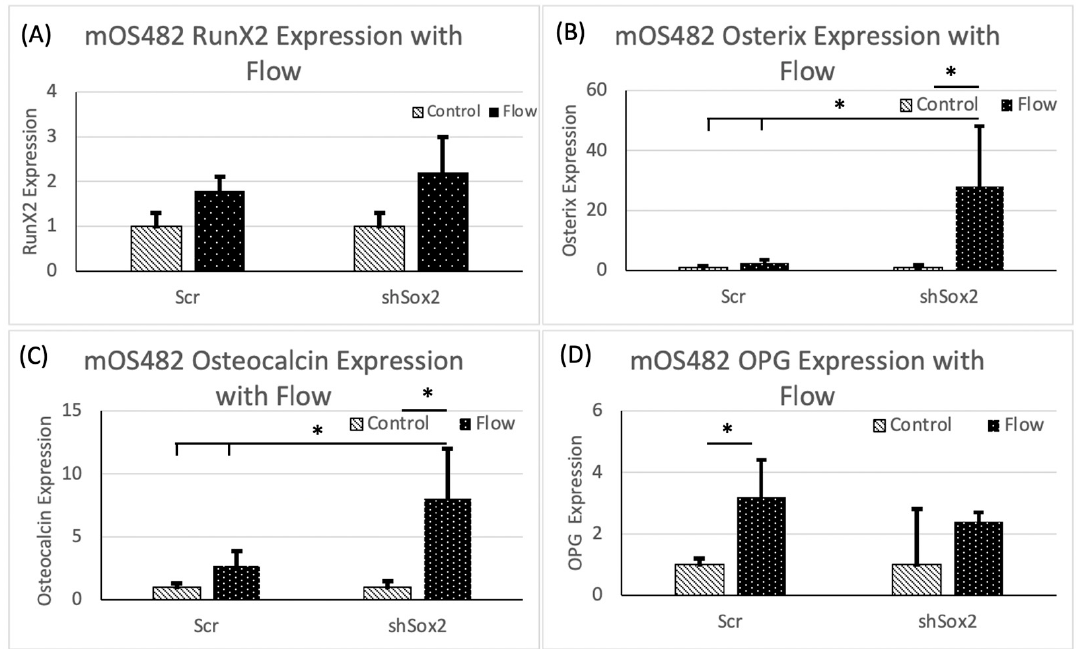
Figure 3. Evaluation of osteogenic gene expression in scr and shSox2 treated cells as a function of FFSS. Quantification of ( A ) Runx2 ( B ) Osterix ( C ) Osteocalcin and ( D ) OPG expression in scr and shSox2 treated cells under control and FFSS conditions * p < 0.01; p value from Mann–Whitney test for statistical significance.